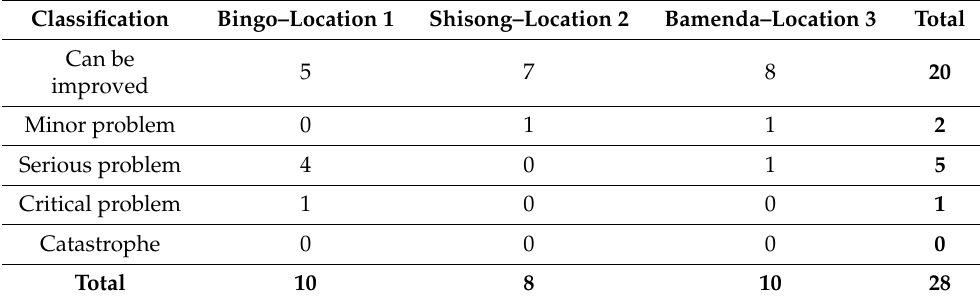
Table 2. Number of problems and their classification, according to the experts. Classification Bingo–Location 1 Shisong–Location 2 Bamenda–Location 3 Total 5 7